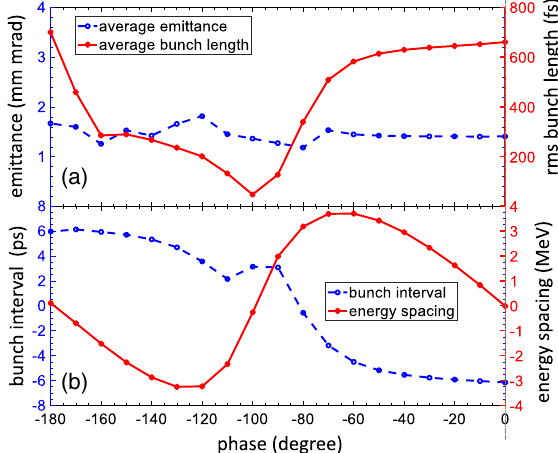
FIG. 6. ASTRA simulation results: (a) average bunch length and average bunch emittance versus the TWA phases, and (b) bunch intervals and the energy spacing versus the TWA phase.